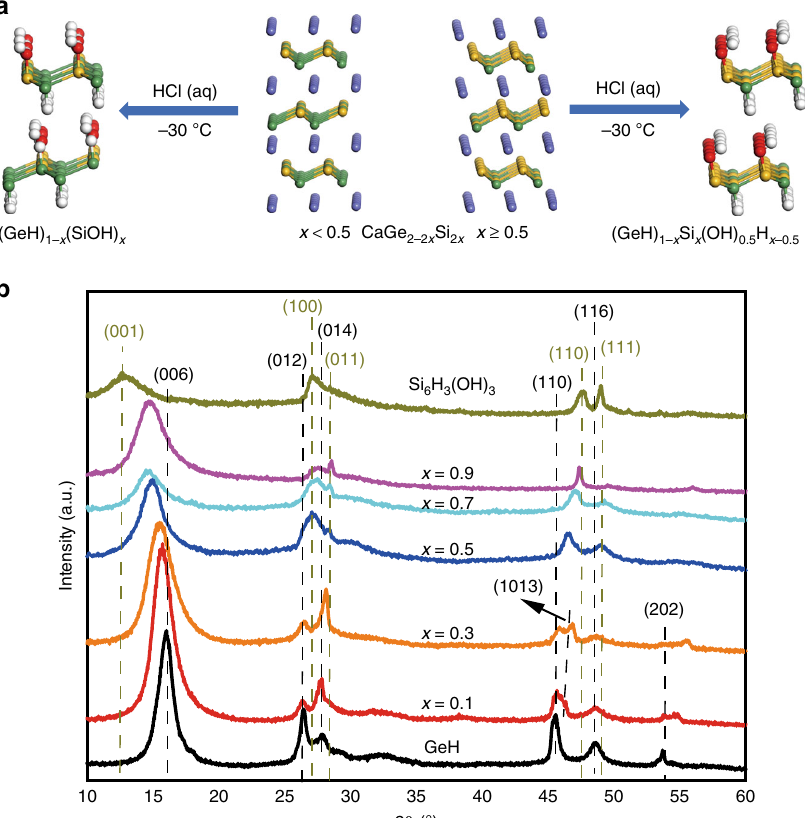
Fig. 1 Crystal structures of CaGe 2 − 2 x Si 2 x and gersiloxenes. a Schematic illustration of topotactic deintercalation of CaGe 2 − 2 x Si 2 x to gersiloxenes (GeH) 1- x (SiOH) x ( x < 0.5) or (GeH) 1- x Si x (OH) 0.5 H x − 0.5 ( x ≥ 0.5) (Ca, blue; Ge, green; H, white; O, red; Si, yellow). b XRD patterns of the topotactic deintercalation products gersiloxenes with varying x ( x = 0.1, 0.3, 0.5, 0.7, 0.9), GeH and Si 6 H 3 (OH) 3 . XRD, X-ray diffraction. Source data are provided as a Source Data fi